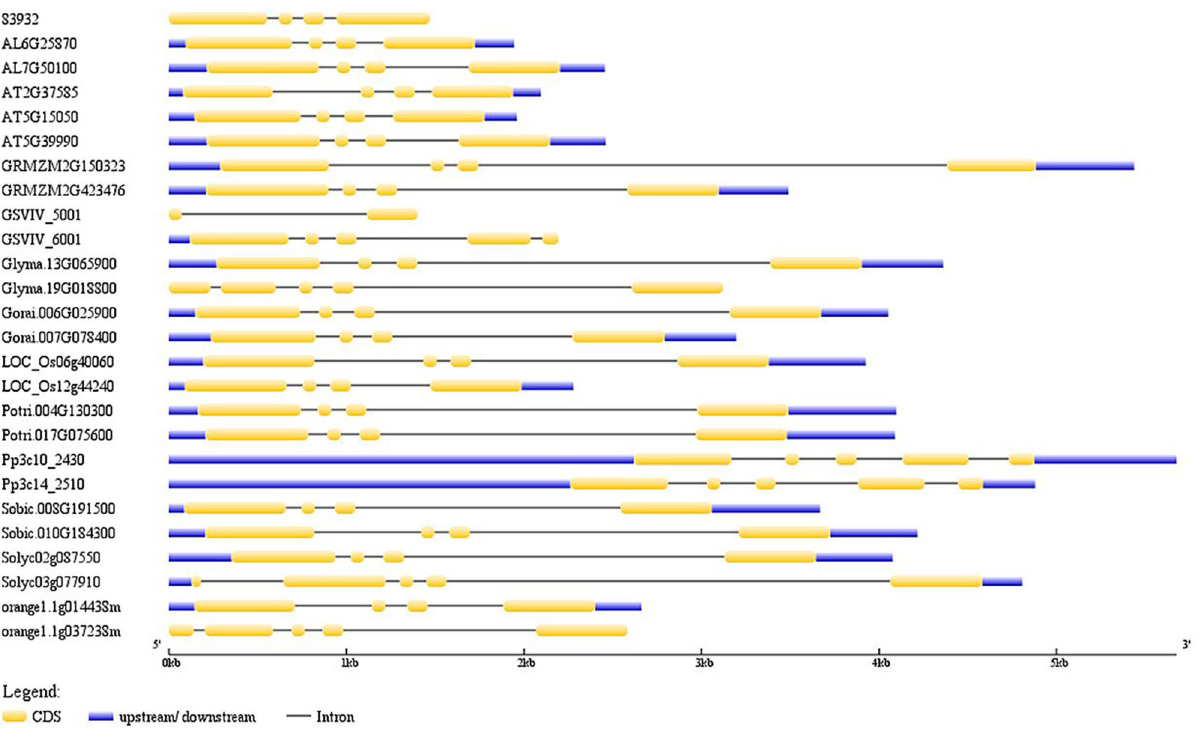
Figure 3. Gene structure display of representative GLCATs from various plant species. Twenty-six proteins representing the diversity of putative GLCATs in the plant kingdom were used for the gene structure analysis as illustrated by using the GSDS 2.0 server 37 . ‘83,932 = putative GLCAT sequence in Sellaginella moellendorffii ; AL = Arabidopsis lyrata ; AT = Arabidopsis thaliana ; GRMZM = Zea mays ; GSVIV = Vitis vinifera ; Glyma = Glycine max ; Gorai = Gossypium raimondii ; LOC = Oryza sativa ; Potri = Populus trichocarpa ; Pp = Physcomitrella patens ;